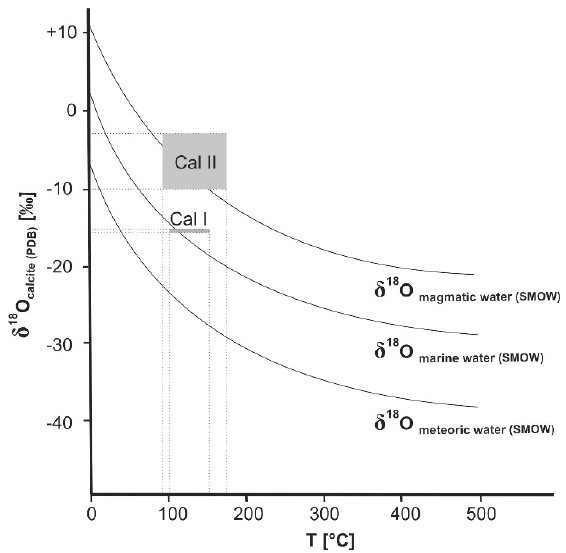
Figure 20. Fractionation curves of δ 18 O PDB calcite as a function of temperature for oxygen isotope equilibration with meteoric water ( δ 18 O = − 10‰), marine water ( δ 18 O = 0‰), and magmatic water ( δ 18 O = +8‰) calculated according to the data of O’Neil et al. [95]. The grey fields show the positions of the two calcite generations Cal I and Cal II from Savda (JAL ‐ 31, JAL ‐ 32). Using the homogenization temperatures of fluid inclusions (Table 5) and the corresponding δ 18 O data (Table 6), the field of calcite I plots close to the fractionation curve of oxygen from marine water.